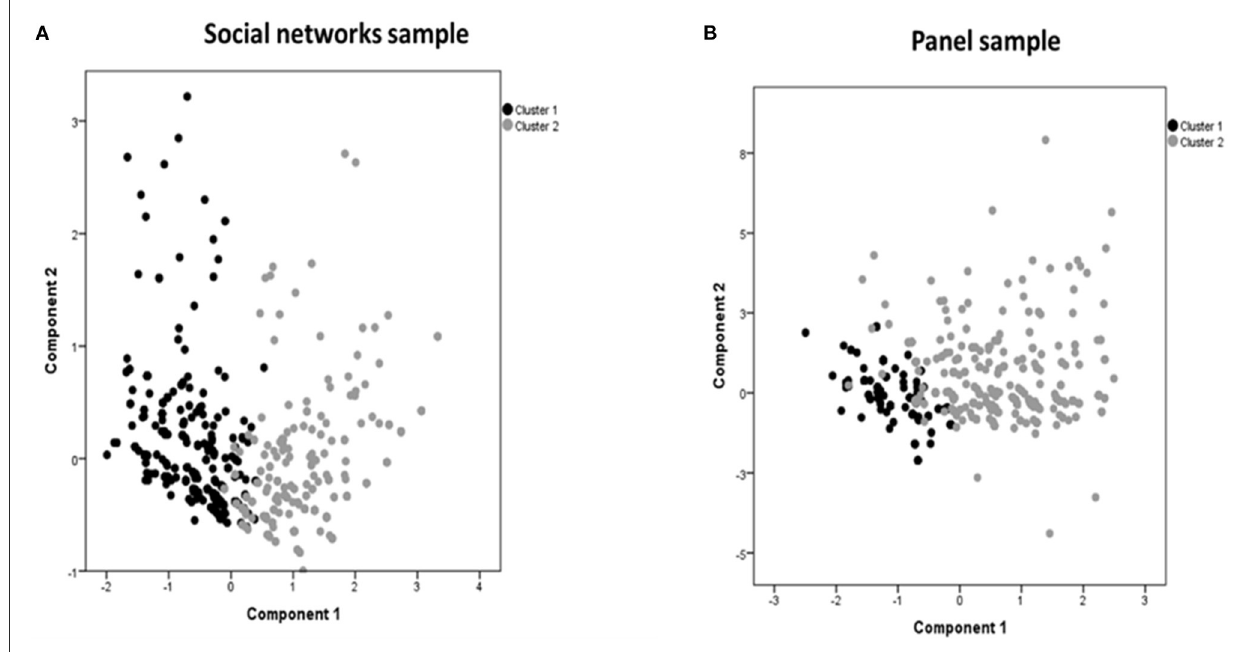
FIGURE1 Cluster analysis grouping participants from the social networks sample (A) and the panel sample (B) according to reasons for not being vaccinated.